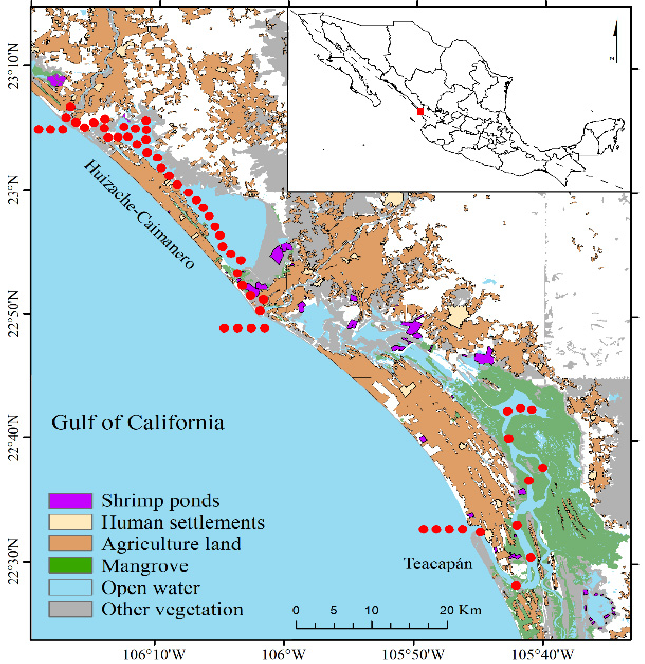
Figure 1. Map of the studied systems indicates the surrounding vegetation and the sampling stations (red dots).